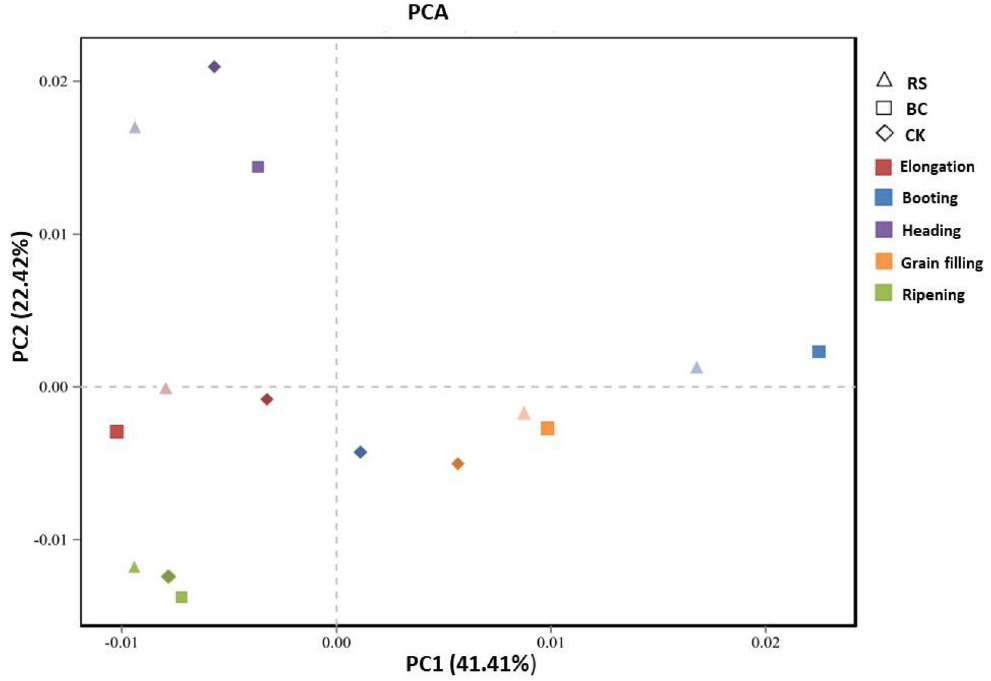
Figure 3. Principal component analysis of the bacterial genera in the rhizosphere soil samples. Treatments: RS rice straw applied at 9000 kg ha −1 , BC biochar applied at 3150 kg ha −1 , CK soil without straw/biochar